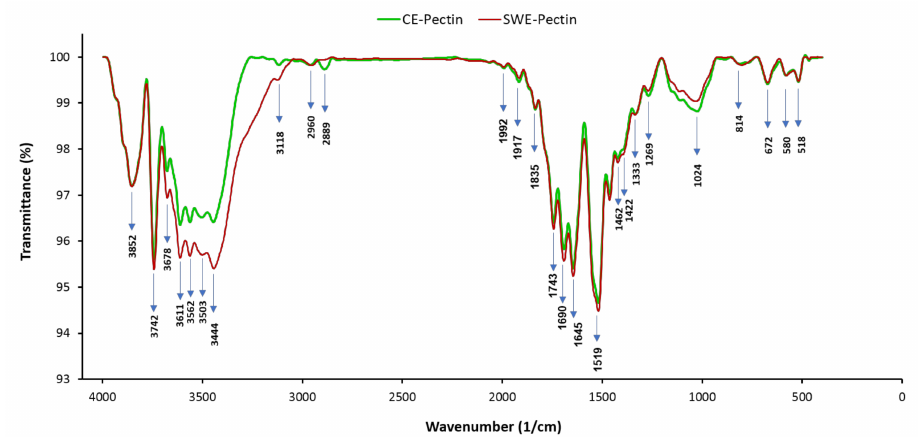
Figure 2. FT-IR spectra of conventionally extracted pectin and SWE